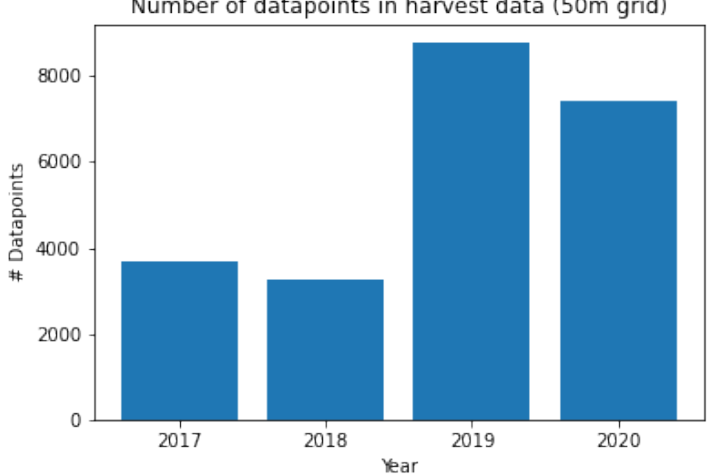
Figure 7. Winter wheat yield data available for training for each of the study years under the chosen 50 × 50 m 2 grid. The number of fields where the above data were obtained during the years 2017, 2018, 2019, and 2020 were 49, 31, 132, and 88,